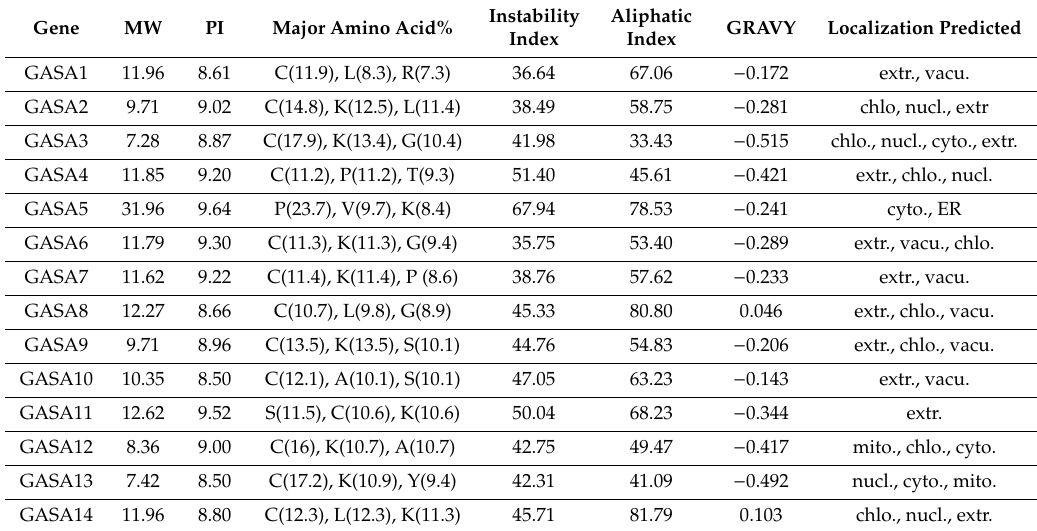
Table 2. Amino acid composition and physiochemical characteristics of GASA proteins.